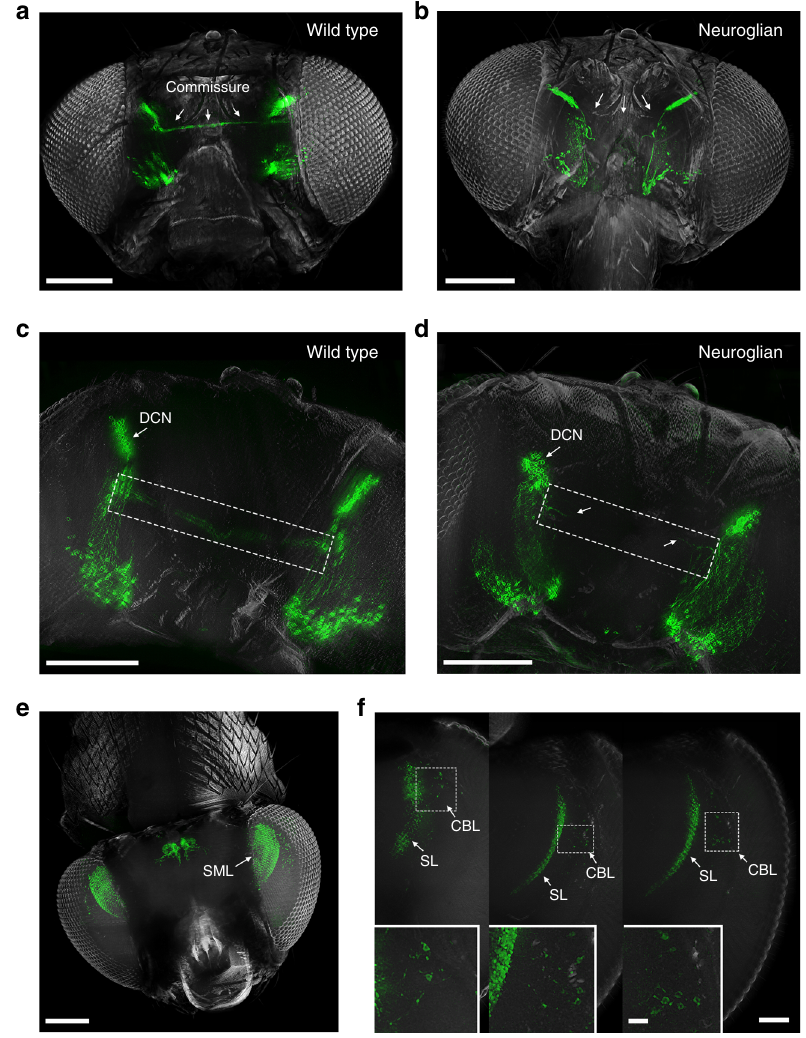
Fig. 4 Imaging of the Drosophila visual system of a FlyClear treated intact adult fl y using optimised aspheric ultramicroscope system. a – f Light-sheet images of GFP expression in visual system. a – d Analysis of interhemispheric circuit defects in Neuroglian mutants. a , c In wild type, clusters of commissural neuron (arrowhead indicate Dorsal cluster neurons, DCNs) in the visual system project across the midline in the central brain (dashed box). Loss of Neuroglian does not affect the ipsilateral organisation of visual neurons but deletes the commissural projections (arrowheads in b ), with a few single fi bres sending short processes towards the midline (arrowheads in d ). e , f Synaptic layer organisation in the visual system. Collumnar interneurons innervating a single medulla layer (SML) are visualised ( e ). Different optical sections indicate separated synaptic (SL) and cell body layers (CBL) ( f ). Images in a , b and e were acquired with a 10x water-immersion objective (Olympus, UMPlanFLN, 0.3NA, WD = 3.5 mm) with custom-made correction of optics for a refractive index of 1.45 (WD = 3.5 mm after correction). Images in c , d and f were acquired with a 25x objective (Olympus, XLPlanN, 1.0 NA, WD = 8 mm). Genotypes: a , c Control – nrg849/ + ; UAS-mCD8::GFP; ato-Gal4 (Females) , b , d Mutant-nrg849/y; UAS-mCD8::GFP; ato-Gal4 (Males) and e , f ; 10x UAS-mCD8:: GFP; R47G08-Gal4 . Scale bars represent 200 µ m in a , b and e , 100 µ m in c , d , 50 µ m in f and 10 µ m in insets in